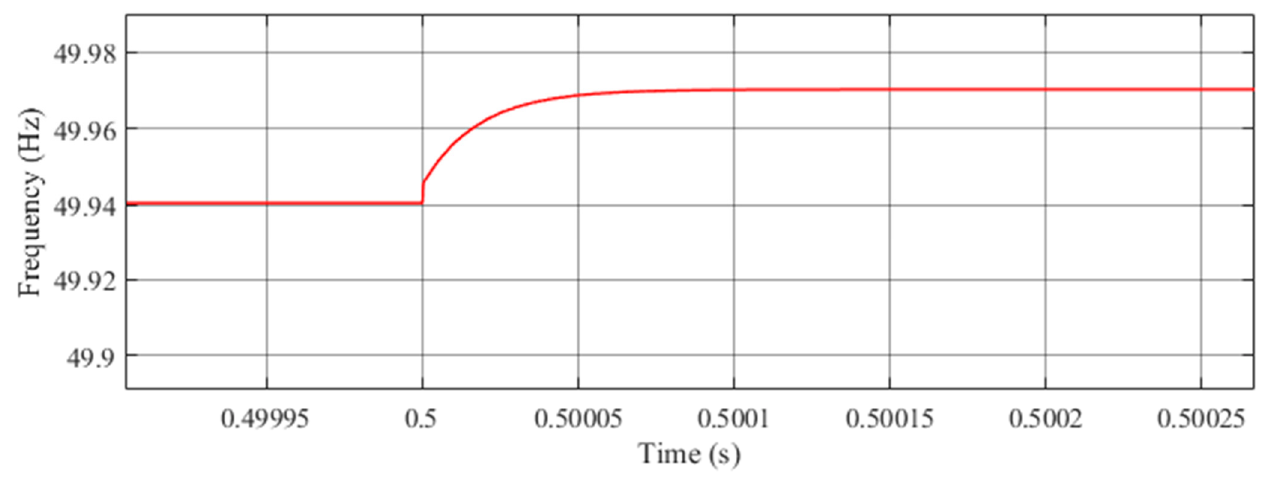
Figure 13. Output current for inductive load in three phase (ABC) frame.